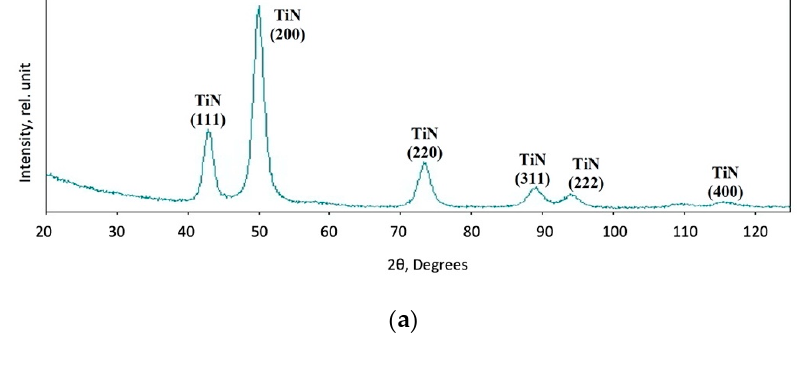
structure, ( b ) and TEM patterns ( c ) of the Ti–Al–N coatings.